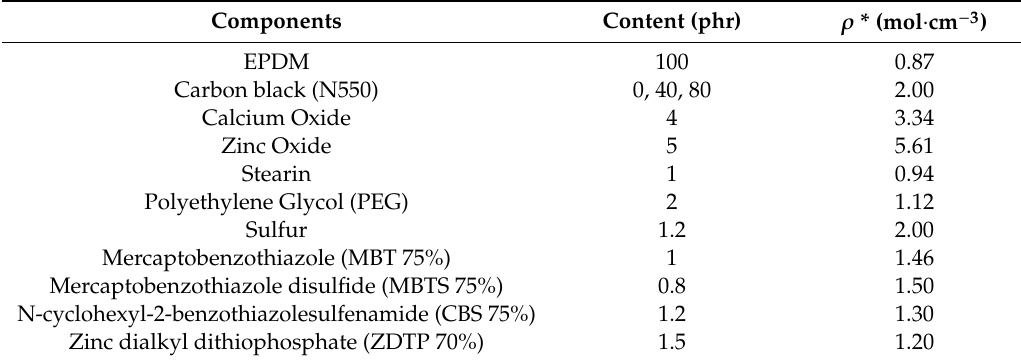
Table 1. Composition of the EPDM